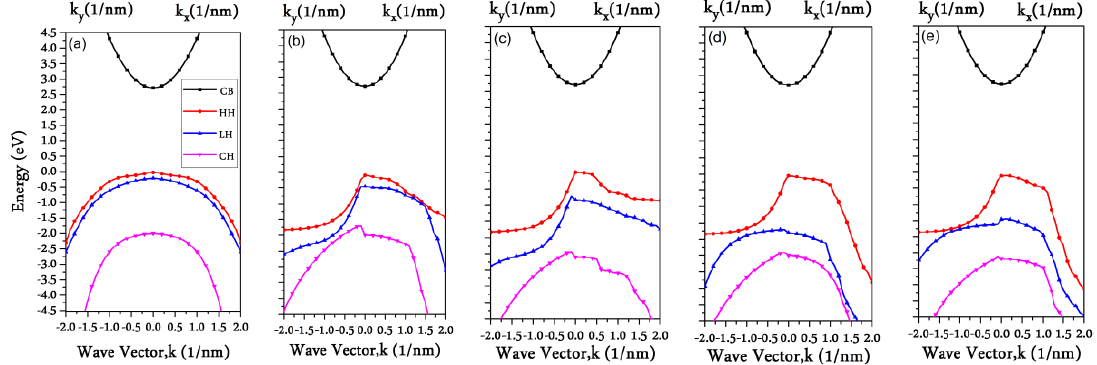
Figure 7. Energy band dispersion profile in ( a ) (0001), ( b ) (101 ̅ 0), ( c ) (101 ̅ 2) ( d ) (112 ̅ 2) and ( e ) (101 ̅ 1) crystal orientation of In 0.17 Ga 0.83 N / GaN QW blue laser.